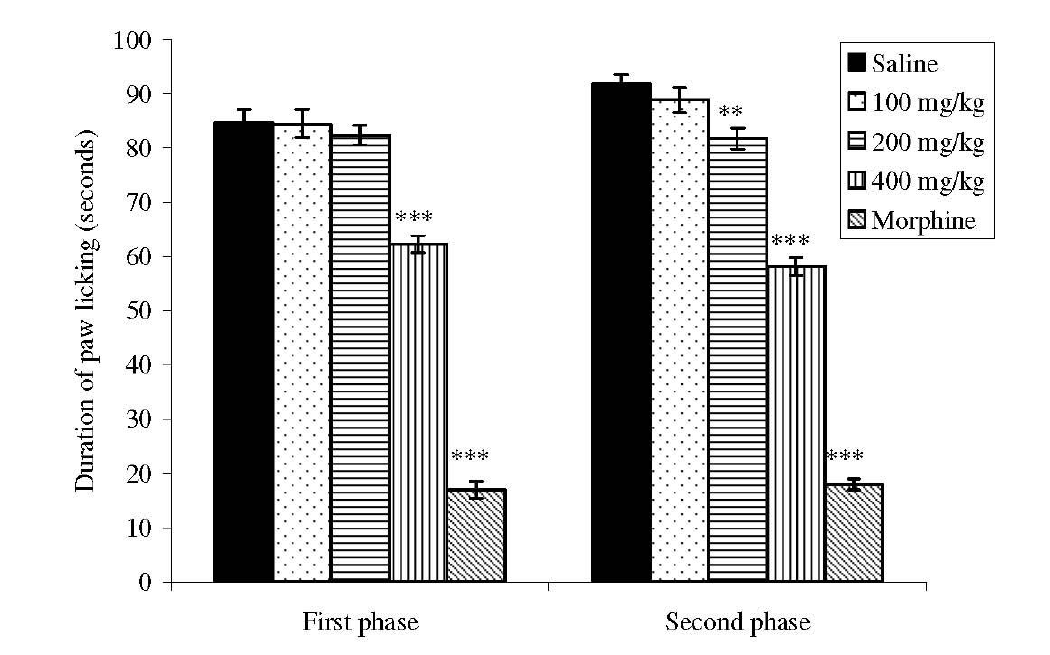
Figure 2. Effects of the ethanol extract from M. platyclada leaves on formalin-induced nociception in mice. First phase = 0–5 min after formalin injection; second phase = 15–30 min. Data are mean  s.e.m. of eight mice. ** P < 0.01; *** P < 0.001 vs. control group.